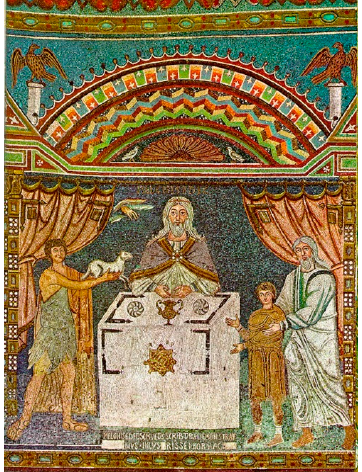
Figure 18. Sant Miquel de Terrassa, wall paintings. Detail of the draperies. © Teresa Llordés (with kind permission).